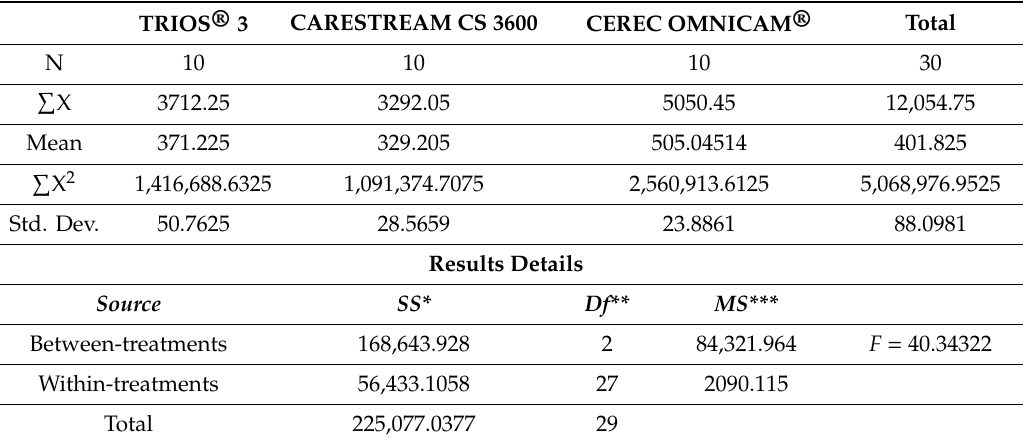
Table 5. Distance between reference lines and test ones in sample 4 with